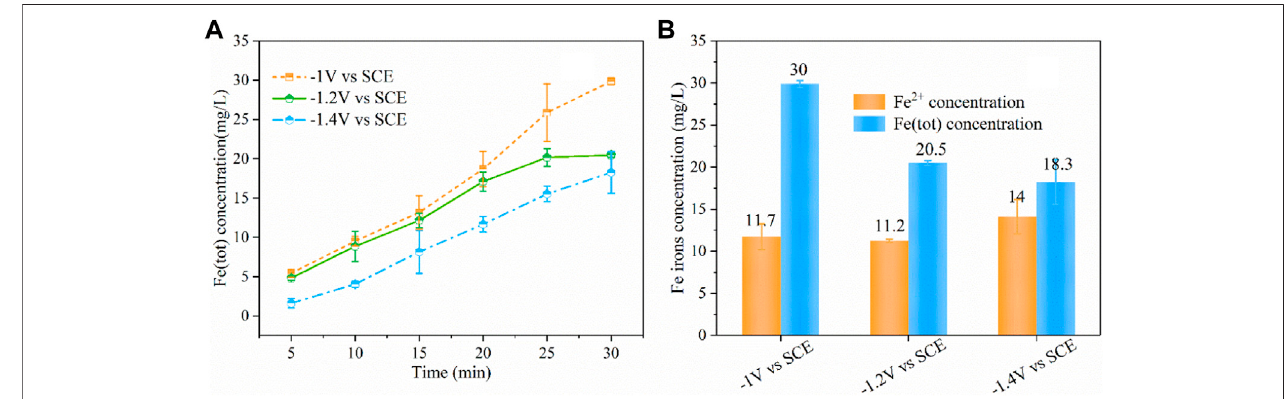
FIGURE 4 | Concentration variations of Fe (tot) under different cathodic potentials (A) , concentration of Fe irons at 30 min under different cathodic potentials (B) . (PNP (cid:1) 100 mg/L, Na 2 SO 4 (cid:1) 3 g/L, pH 0 (cid:1) 3.0).